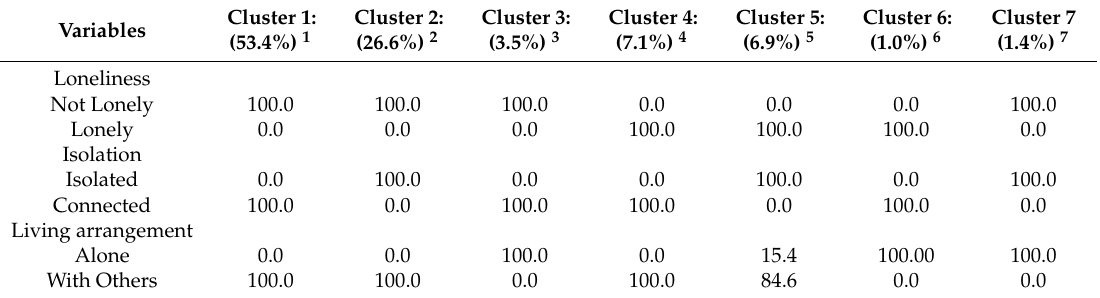
Table 2. Loneliness, isolation, and living alone (LIL) combination distribution of the community-based sample—seven clusters (%).